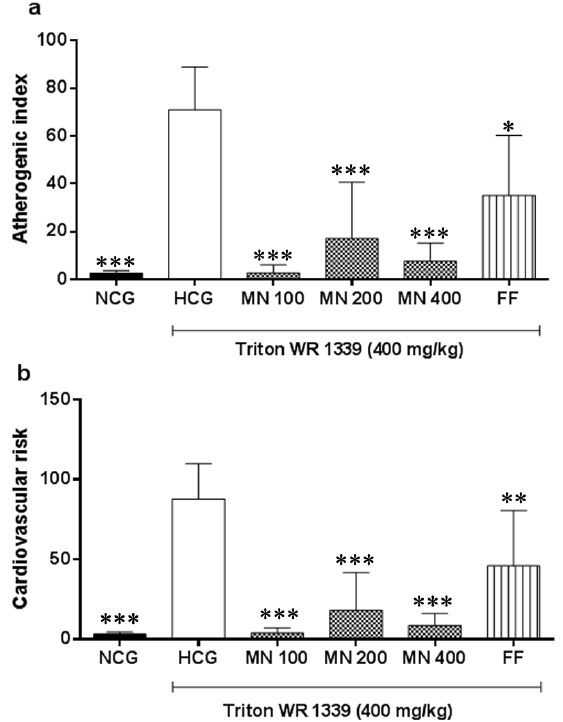
Figure 3 - The atherogenic index ( a ) and cardiac risk factor ( b ) of Triton WR-1339-induced hyperlipemic rats (HCG) treated with Morus nigra infusion extract (MN) or fenofibrate (FF). Values are expressed as means ± SEM ( n =6-8). *** p ˂0.001 and ** p ˂0.01 compared with HCG